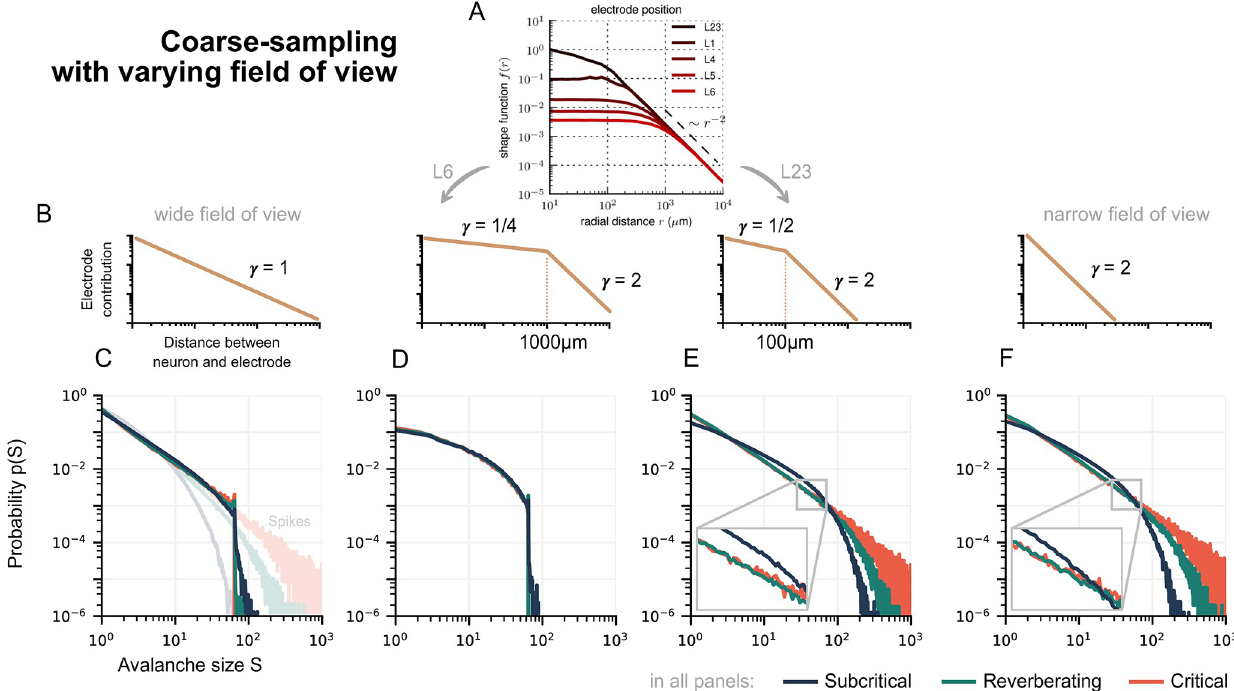
Fig 4. The signal of an extracellular neuronal recording depends on neuronal morphologies, tissue filtering, and other factors, which all impact the coarse-sampling effect. In effect, an important factor is the distance of the neuron to the electrode. Here, we show how the distance-dependence, with which a neuron’s activity contributes to an electrode, determines the collapse of avalanche distributions. A : Biophysically plausible distance dependence of LFP, reproduced from [38]. B : Sketch of a neuron’s contribution to an electrode at distance d , as motivated by (A). The decay exponent γ characterizes the ik field of view. C–F : Avalanche-size distribution p ( S ) for coarse-sampling with the sketched electrode contributions. C, D : With a wide-field of view, distributions are hardly distinguishable between dynamic states. In contrast, for spiking activity the differences are clear (light shades in C). E, F : With a narrower field of view, distributions do not fully collapse on top of each other, but differences between reverberating and critical dynamics remain hard to identify. Parameters : Inter-electrode distance d E = 400 μ m and time-bin size Δ t = 8 ms. Other parameter combinations in Fig B in S1 Text.